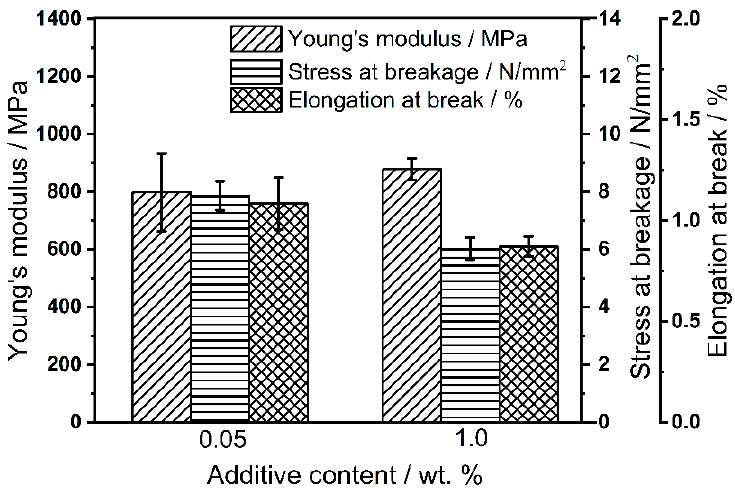
Figure 11. Mechanical properties of the tensile strength specimens from Silica(+)